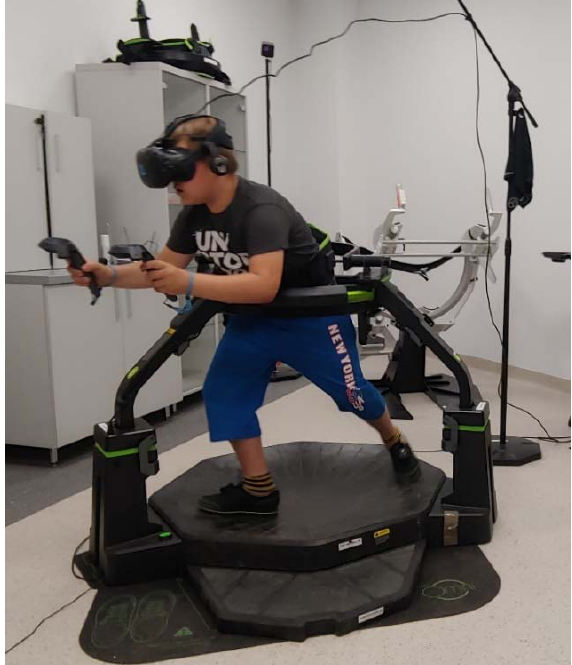
Figure 1. Test stand: participant on an OMNI omnidirectional treadmill playing an active video game (AVG) in immersive virtual reality (IVR).